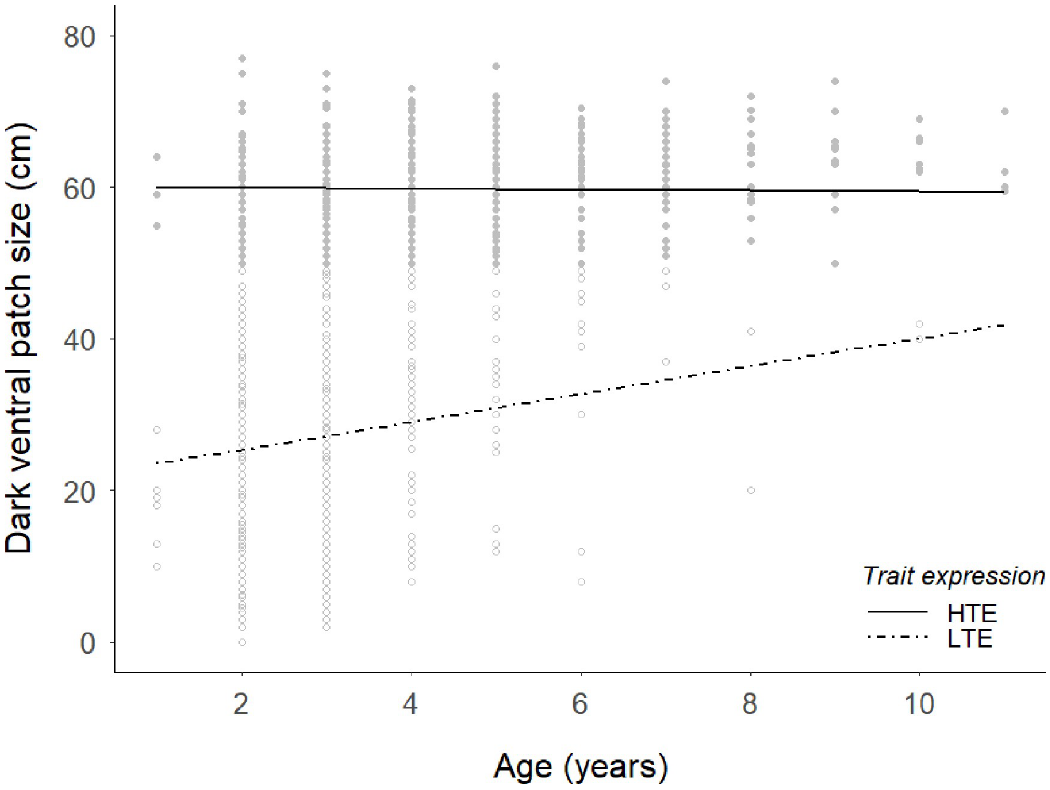
Fig 2. Predictions of the dark ventral patch size (cm) against age (years) from model of Table 1 for the two trait-expression groups of red deer males (HTE: solid line; LTE, dashed line). Points are raw, untransformed data for the dark ventral patch size (HTE: grey filled points; LTE, grey open